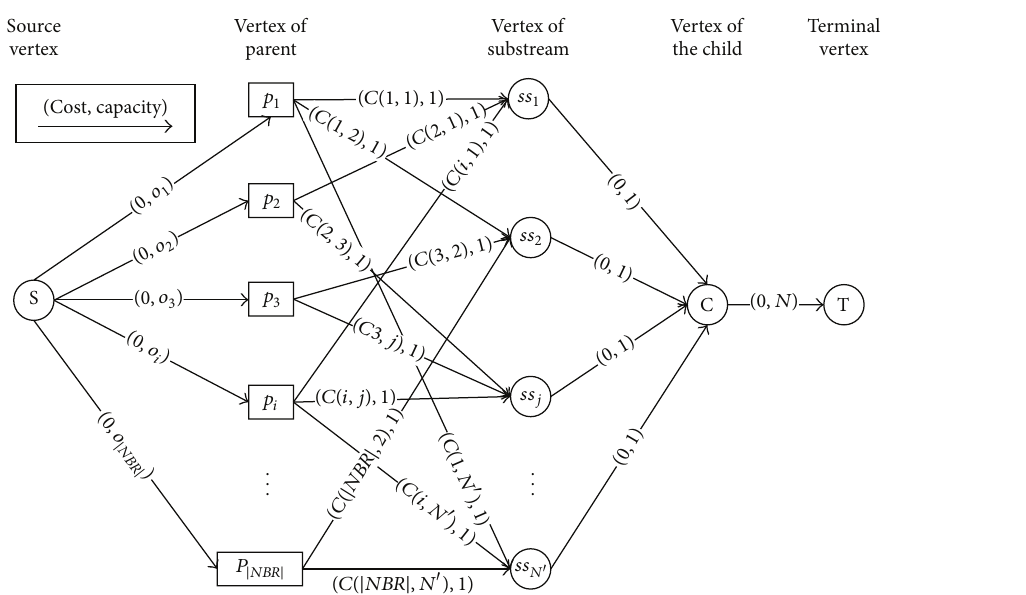
Figure 3: A min-cost-transformation